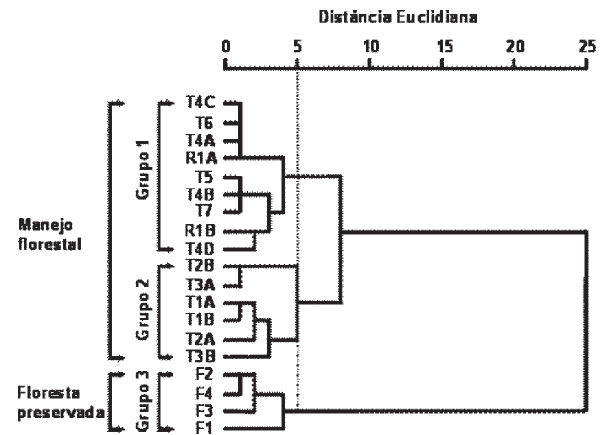
Figura 2. Dendrograma resultante da análise de agrupamento das variáveis explicadas pelo fator 1 da análise